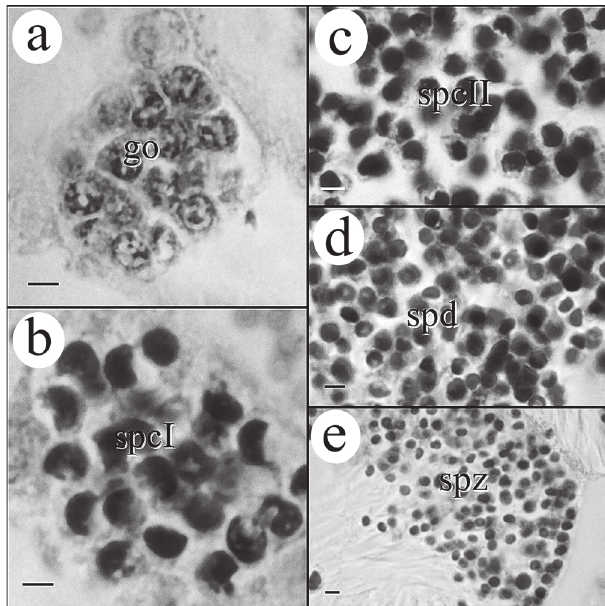
Fig. 3. Photomicrographs of a histological section from male Alphestes afer spermatogenesis stages. (a) , go = spermatogonias, (b) , spcI = spermatocytes in first stage (bar = 5 μ m); (c) ,spcII = secondary spermatocytes (bar = 2.5 μ m); (d) , spd = spermatides (bar = 2 μ m); (e) , spz = spermatozoa (bar = 2 μ m) (18.6 cm T ; September 2009). L